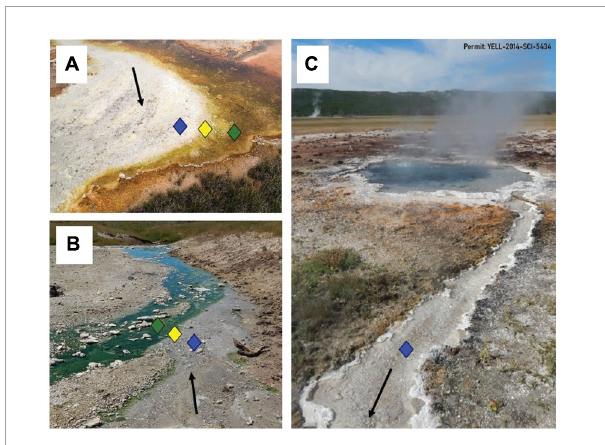
FIGURE1 Hot spring outflows with depictions of the photosynthetic fringe. Locations above (blue), at (yellow), and below (green) the photosynthetic fringe are indicated by respective diamonds. Black arrows indicate a general flow of water away from the source. (A) The visual representation of the photosynthetic fringe in the outflow of a basic spring, BP, where the white sinter in the outflow meets orange phototrophic mats along the edge of the outflow. (B) The visual representation of the photosynthetic fringe in the outflow of an acidic spring, CF, where the clear outflow meets green phototrophic mats. (C) An example of the start of a hot spring outflow channel from a basic hot spring, BP, before reaching its photosynthetic